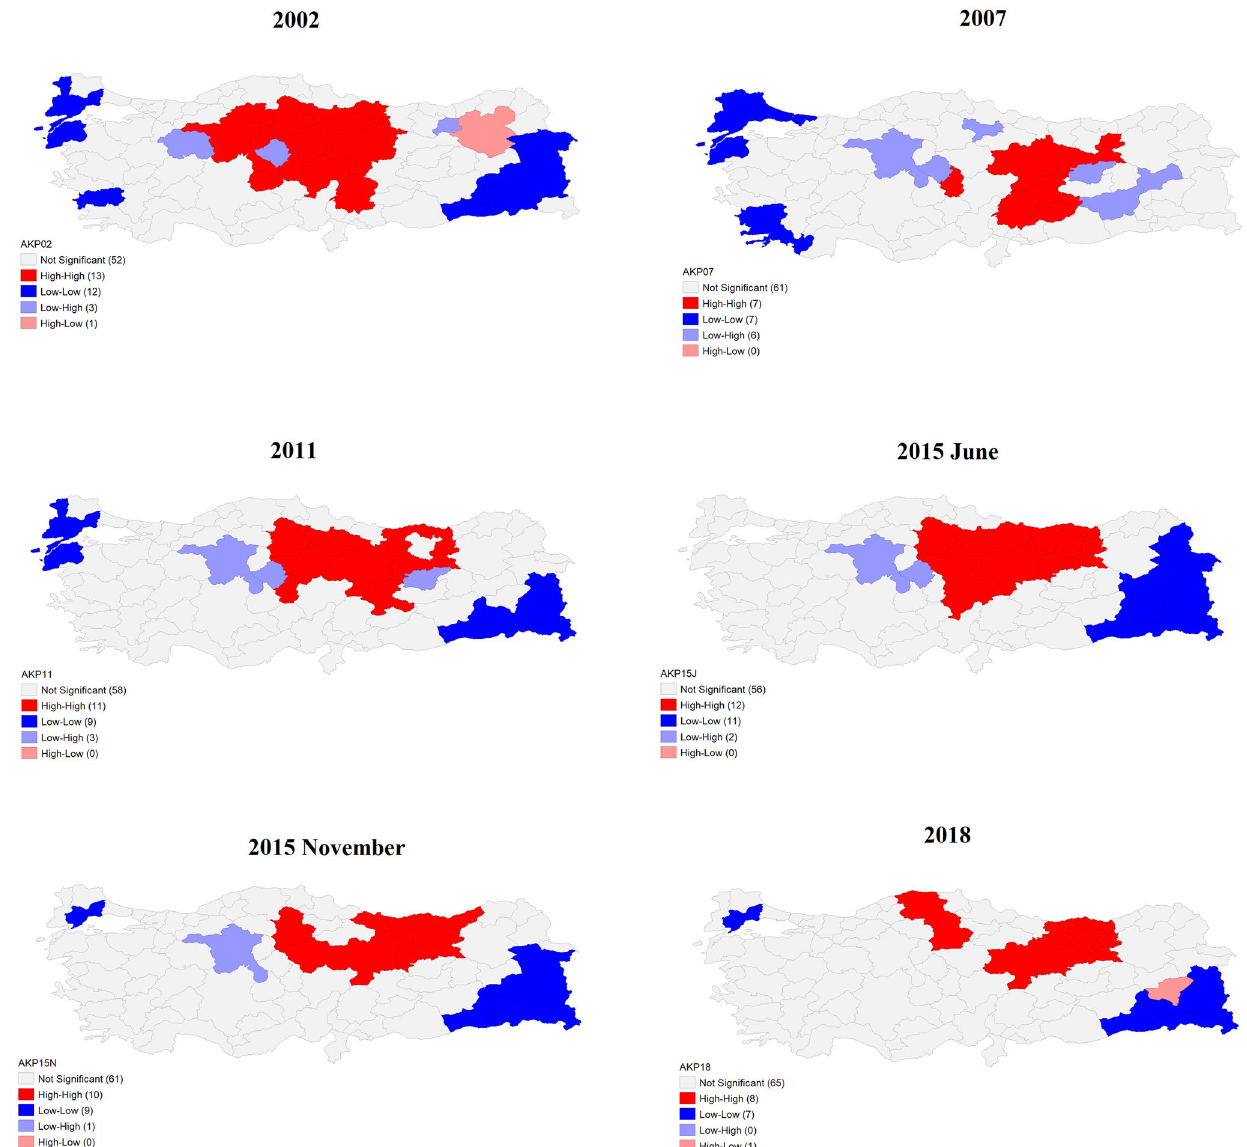
Fig. 4 LISA maps for the AKP. LISA maps have been obtained via queen